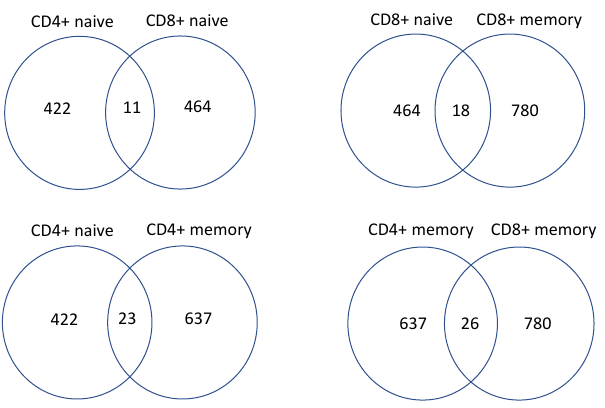
Figure 4. Overlapping views of shared genes that were significantly up/down-regulated by cytokines for different T cell subsets.